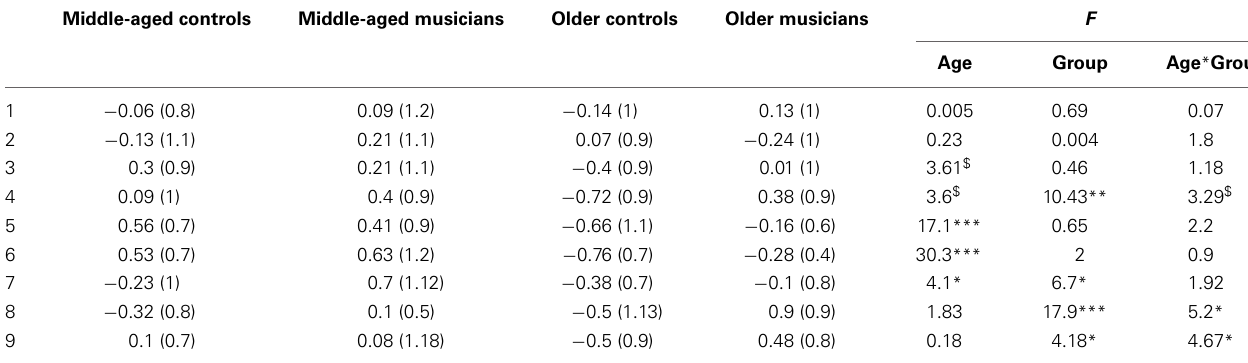
Table 4 | Means ( SD s) for neuropsychological Z scores, as well as F -values resulting from the Two-Way ANOVAs (trend/significance p -values: